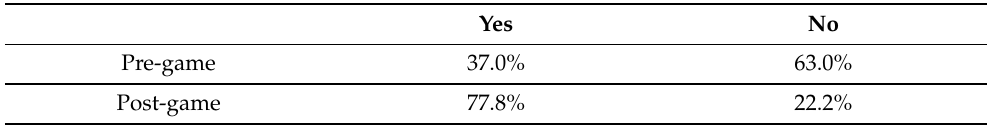
Table 2. Response distribution (yes/no) to question “Do you think there may be air pollution inside our